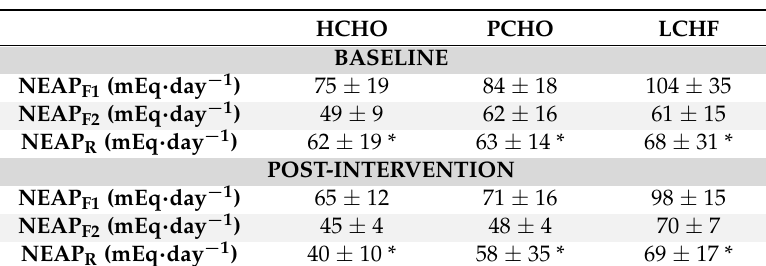
Table 3. Net endogenous acid production (NEAP) estimations for high carbohydrate (HCHO), periodized carbohydrate (PCHO) and low carbohydrate, high fat (LCHF) groups using two